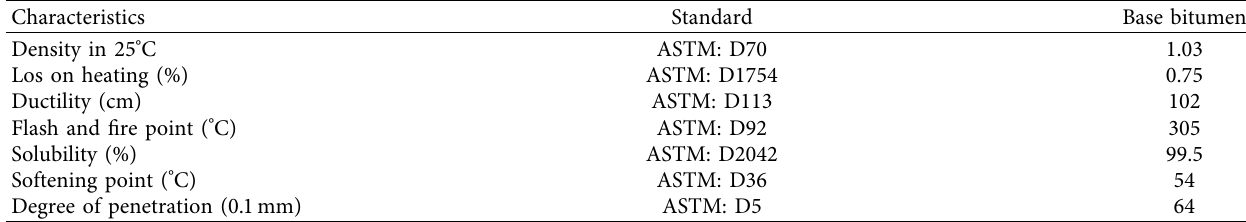
Table 2: The characteristics of base bitumen.